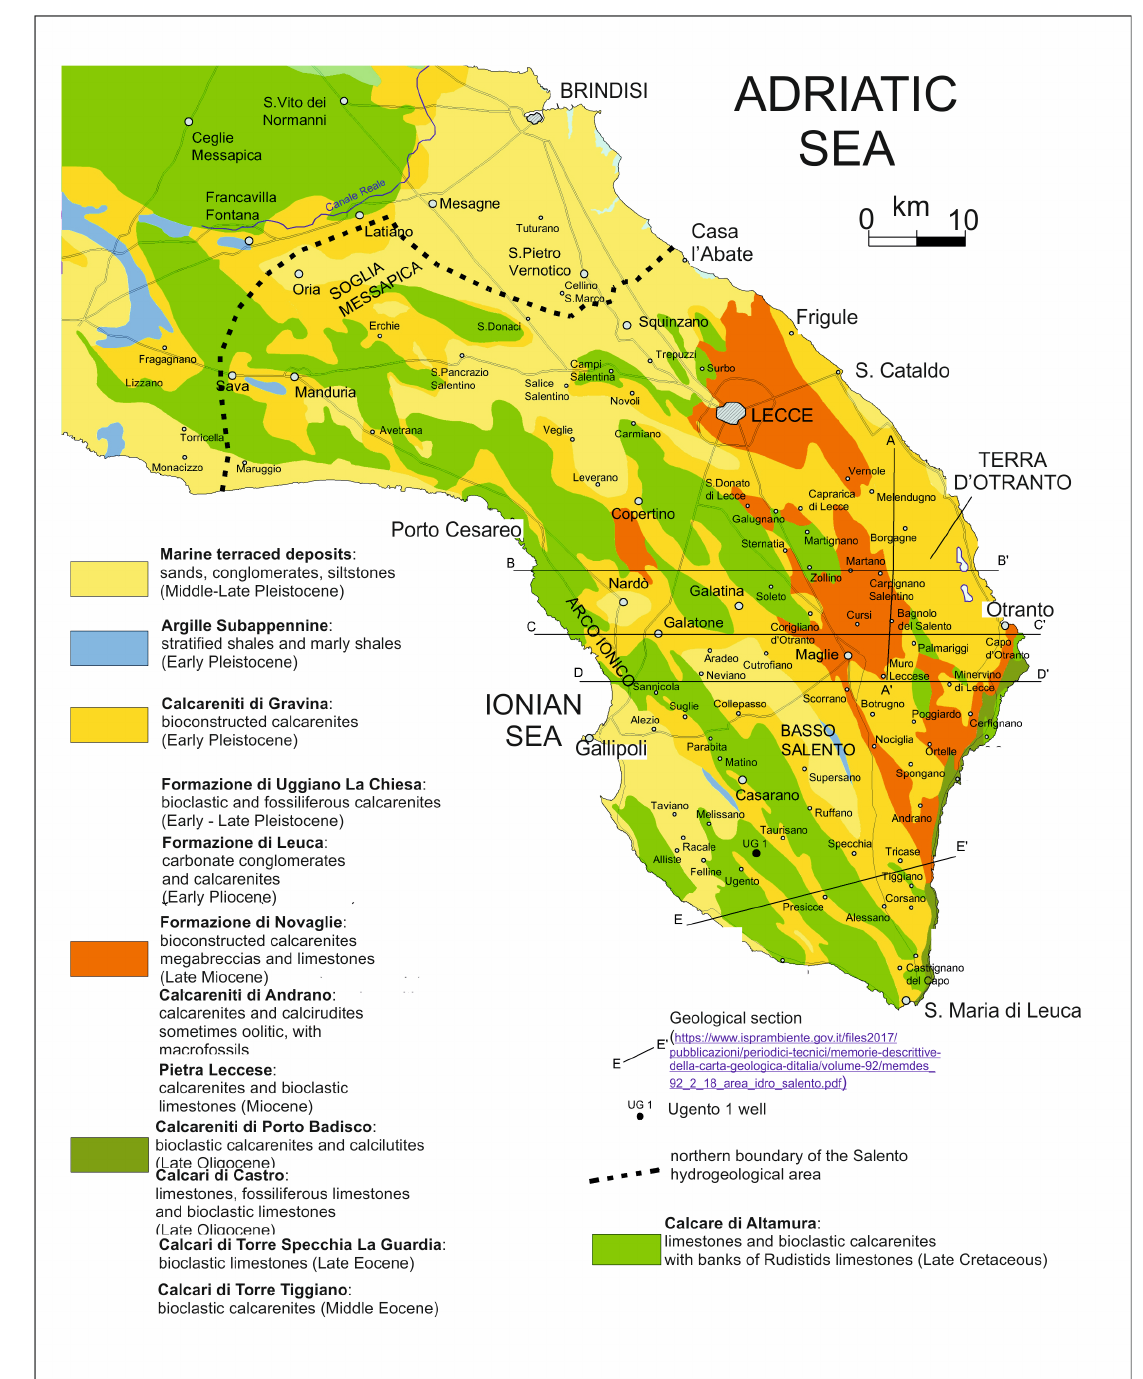
Figure 1. Geologic map of the Salento Peninsula (modified after https://www.isprambiente.gov.it/files2017/pubblicazioni/periodici ‐ tecnici/memorie ‐ descrittive ‐ del la ‐ carta ‐ geologica ‐ ditalia/volume ‐ 92/memdes_92_2_18_area_idro_salento.pdf; accessed on 17 De ‐ cember 2022).